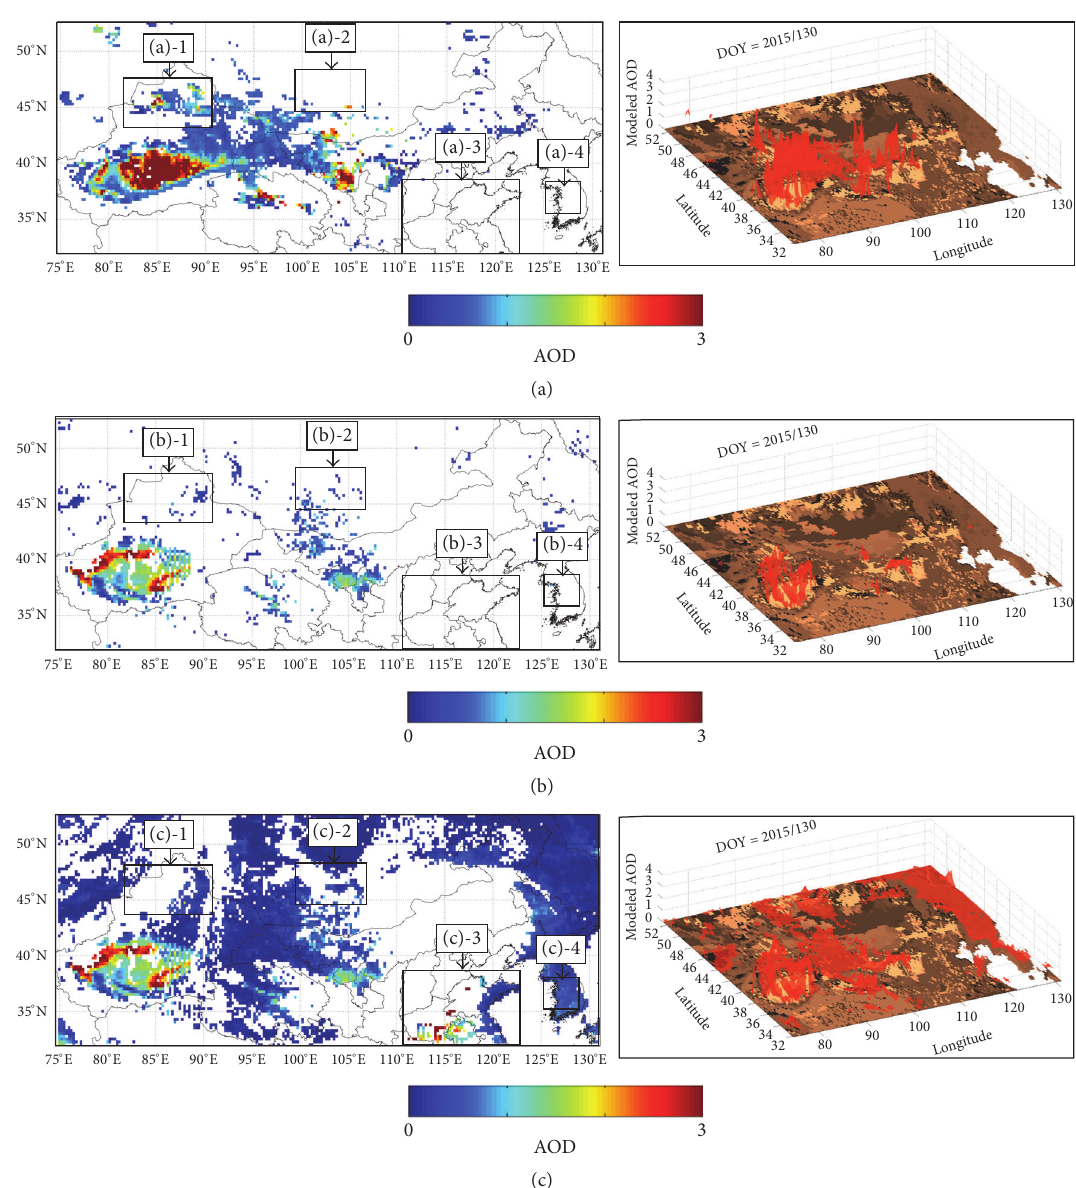
Figure 7: Spatial distribution of AOD in the desert regions of East Asia in day of year 130 in 2015. (a) Modeled AOD based on SMOS soil moisture and GLDAS wind speed, (b) MODIS AOD with Angstrom exponent mask (AE > 0.35, blown dust), and (c) observed AOD from MODIS without Angstrom exponent mask. Images in right column indicate its left side’s 3D values,